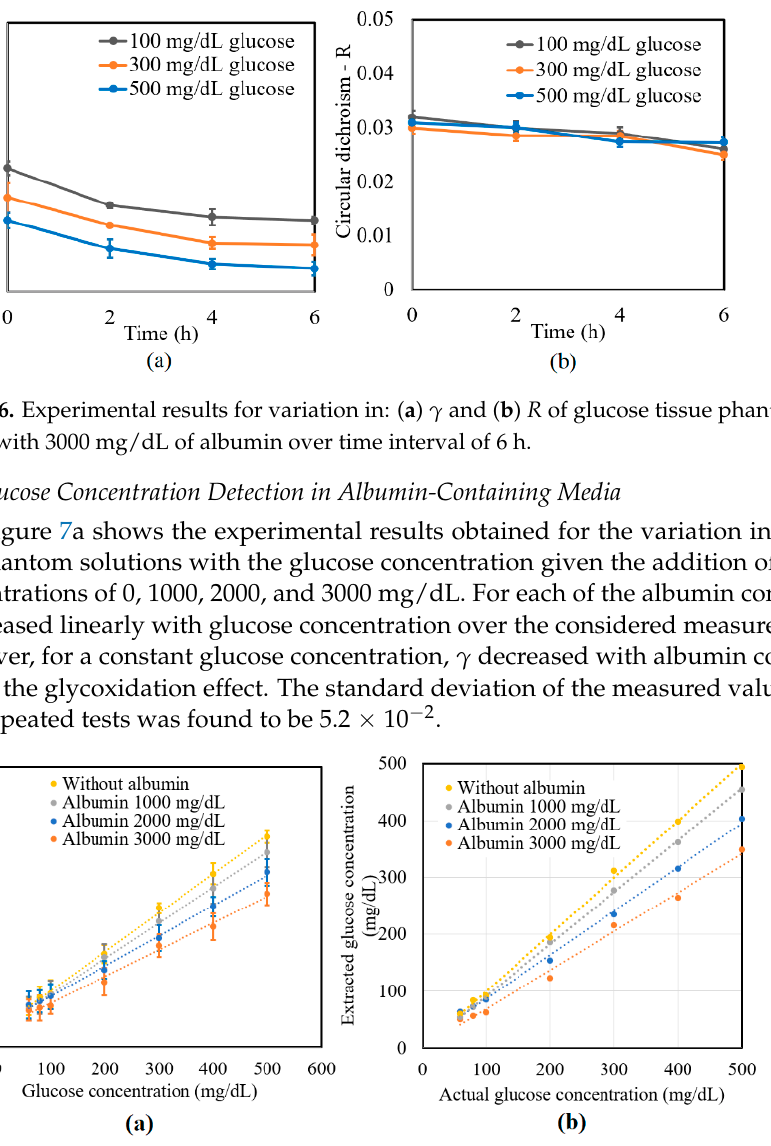
Figure 7. Experimental results for variation in: ( a ) γ and ( b ) R of glucose tissue phantom solutions mixed with 3000 mg/dL of albumin over time interval of 6 h. Table 3. Extraction errors for glucose concentration of tissue phantom solutions without albumin. Actual glucose concentration (mg/dL)